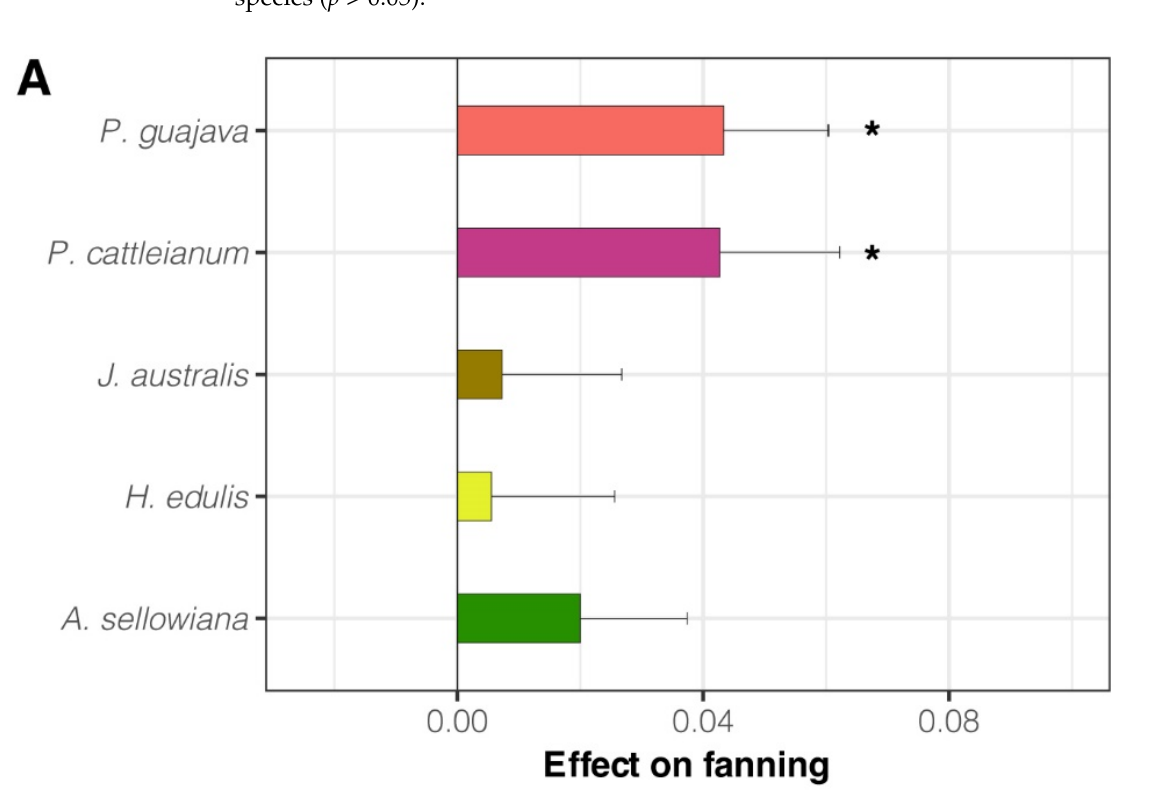
Figure 2. Effect of fruit volatile exposure on Anastrepha fraterculus sp. 1 male calling behavior, estimated through wing fanning ( A ) and salivary glands exposure ( B ). The figure shows the mean ( ± SE) effect on the male calling index (the difference between the calling index of exposed males and non-exposed males). Asterisks indicate significant differences between exposed and non-exposed males. Wing fanning: Psidium guajava p = 0.004, Psidium cattleianum p = 0.034; Salivary glands exposure: P. cattleianum p < 0.001. 4. Discussion On the basis of the well-known enhancement of A. fraterculus sp. 1 male sexual behavior after exposure to guava fruit volatiles [34–36,38,39], we hypothesized here that other native host fruits trigger a similar response on males of this important pest of South America. Therefore, we compared the effect of volatile exposure on male mating success